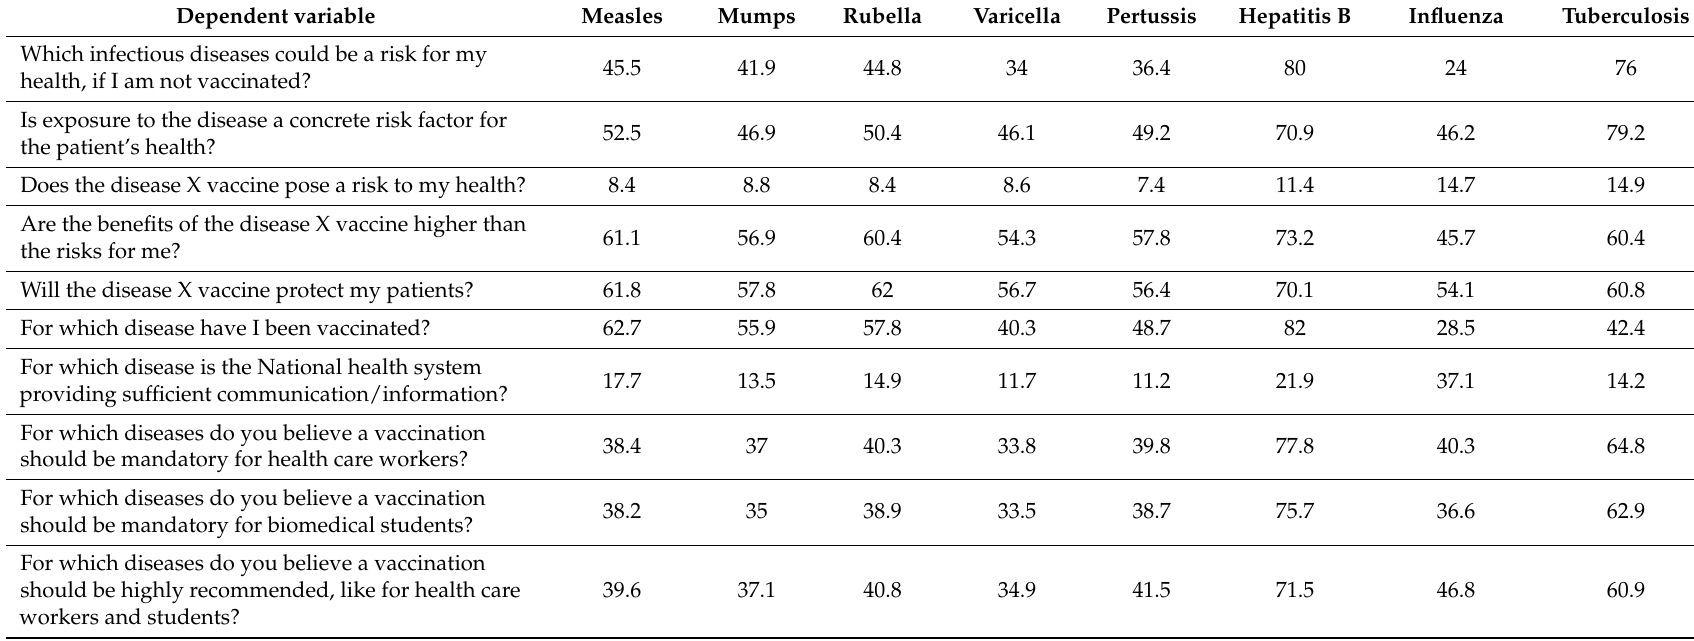
Table 1. Percentages of positive (agreement) answers on knowledge, attitude and